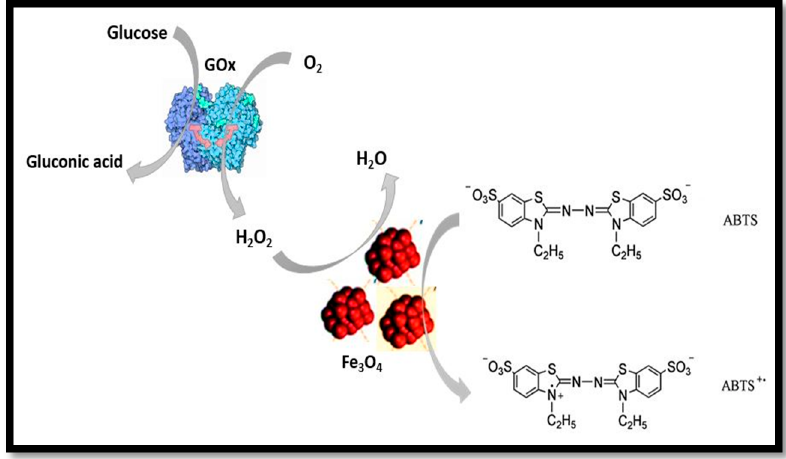
Figure 2. Colorimetric detection of H 2 O 2 and glucose based on Fe 3 O 4 nanozyme as peroxidase mimic.